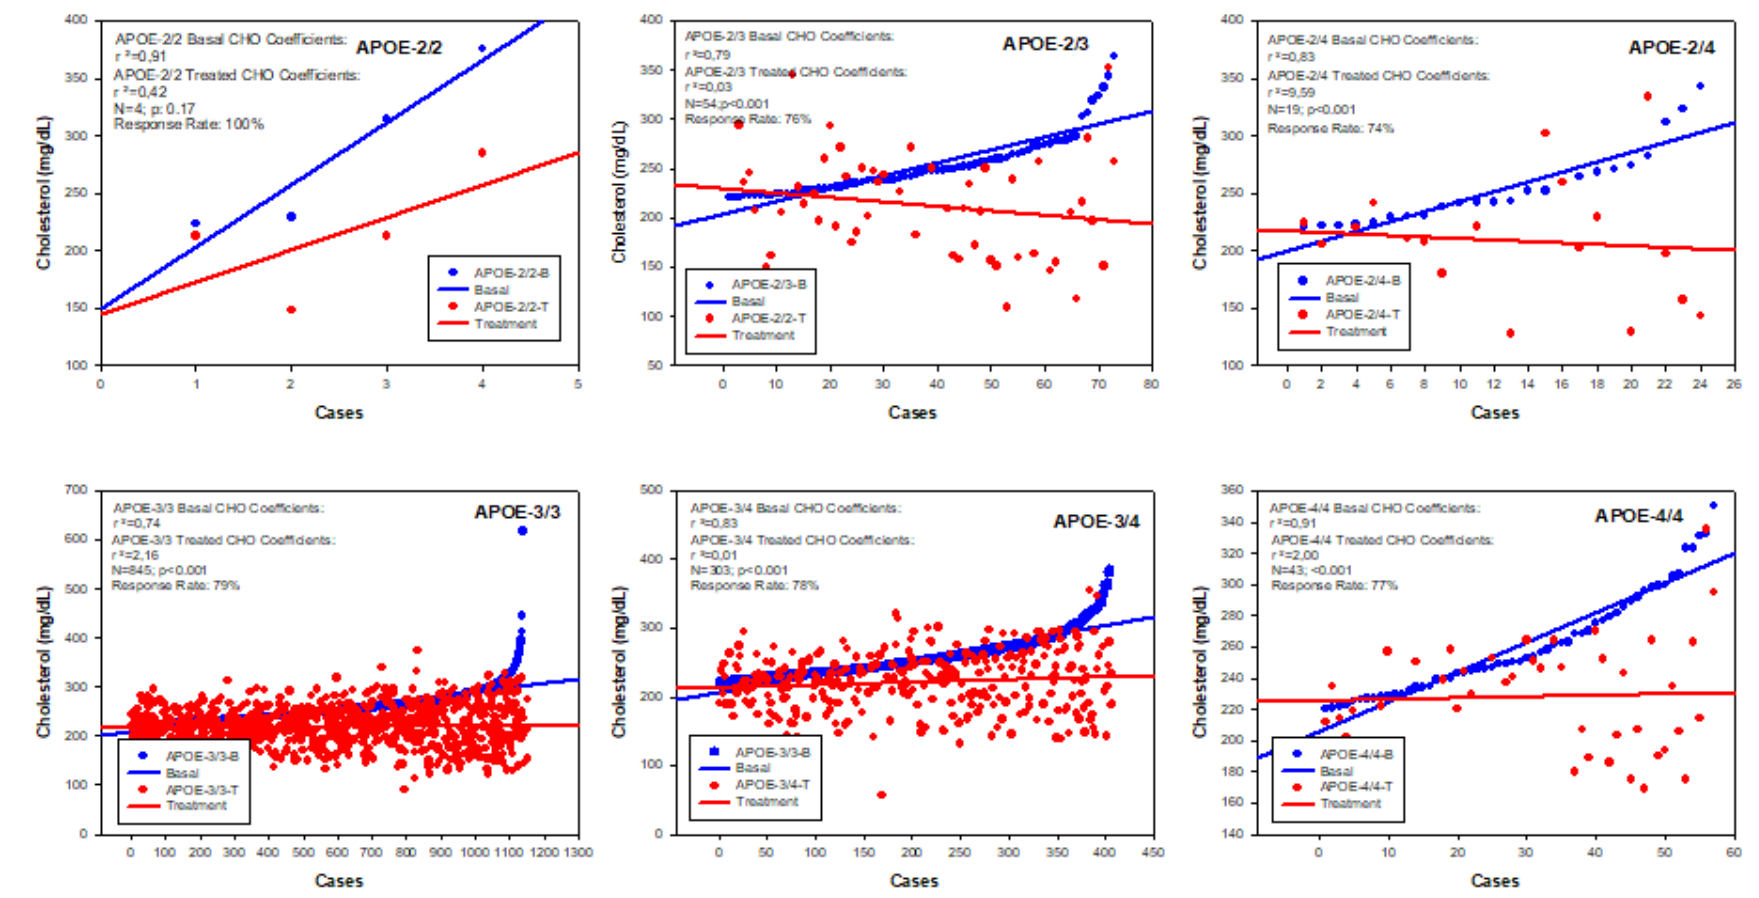
Figure 8. APOE -related individual response of cholesterol to a hypolipemic treatment (Atorvastatin + LipoEsar) in hypercholesterolemic patients with Alzheimer’s disease.